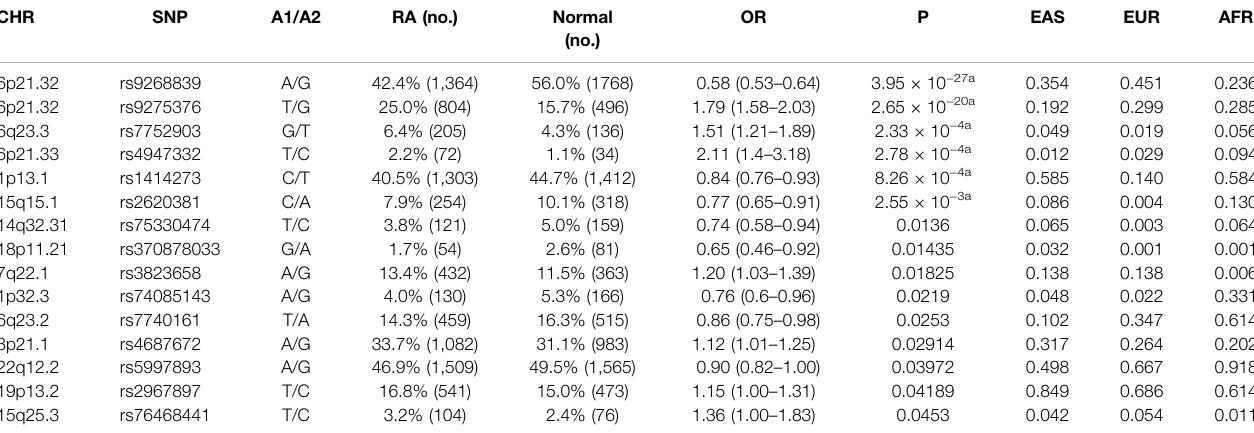
a FDRcorrections werenot shown in the table whileonly p < 2.55 × 10 − 3 is signi fi cant in the table with FDRcorrection. EAS, EUR, and AFRrepresent allele frequency ofA1 in East Asian, EuropeanandAfricanpopulationsbasedon1,000Genomedataset.AlltheORand p -valuearereferringtoA1whiletakingA2asreference.Bayesianlogisticregressionmodeladjustedfor covariates including gender, age, and BMI, were applied as the statistical